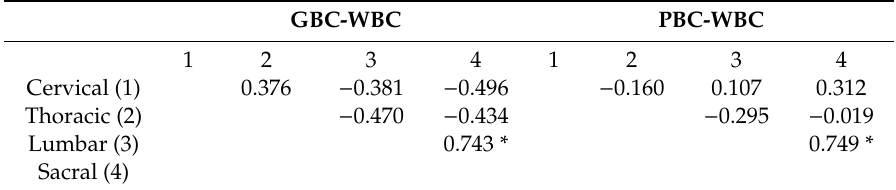
Table 5. Correlation of spinal alignment changes with and without carrying a